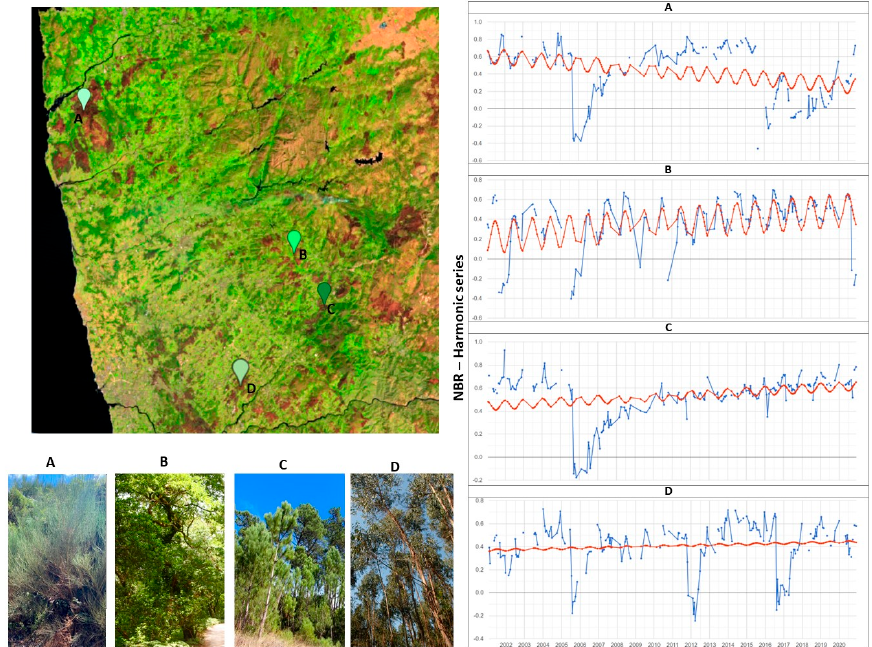
Figure 5. Demonstration of the harmonic fit of four time series in pixels. The blue line represents the real NBR values, and the red line represents the adjusted harmonic model based on the NBR values for the analysis period 2001–2020. The four chosen points refer to different pixels that illustrate types of vegetation: ( A ) bushes; ( B ) oaks; ( C ) pines; and ( D ) eucalyptus. The Landsat 8 image was created with RGB composite (5/4/3).